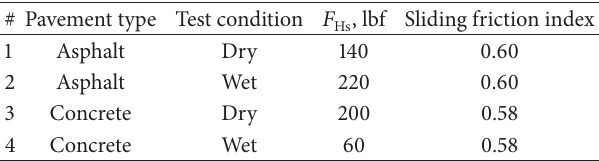
Table 6: Summary of friction test results from the four tests reporting values of their associated sliding friction